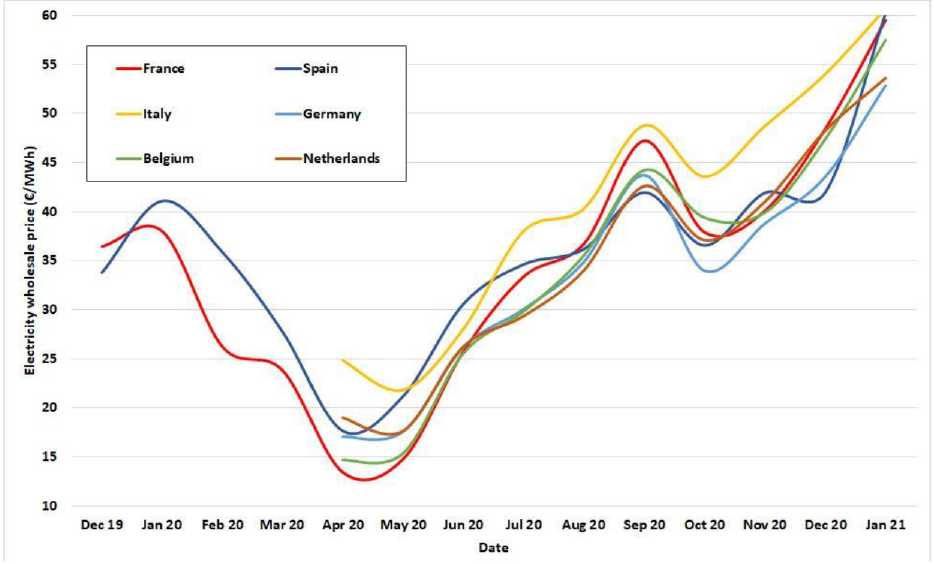
Figure 10. European electricity prices in COVID-19 time. Source: own work based on ESIOS data [5]. Portugal electricity prices have not been represented in Figure 10, because they are practically identical to those of